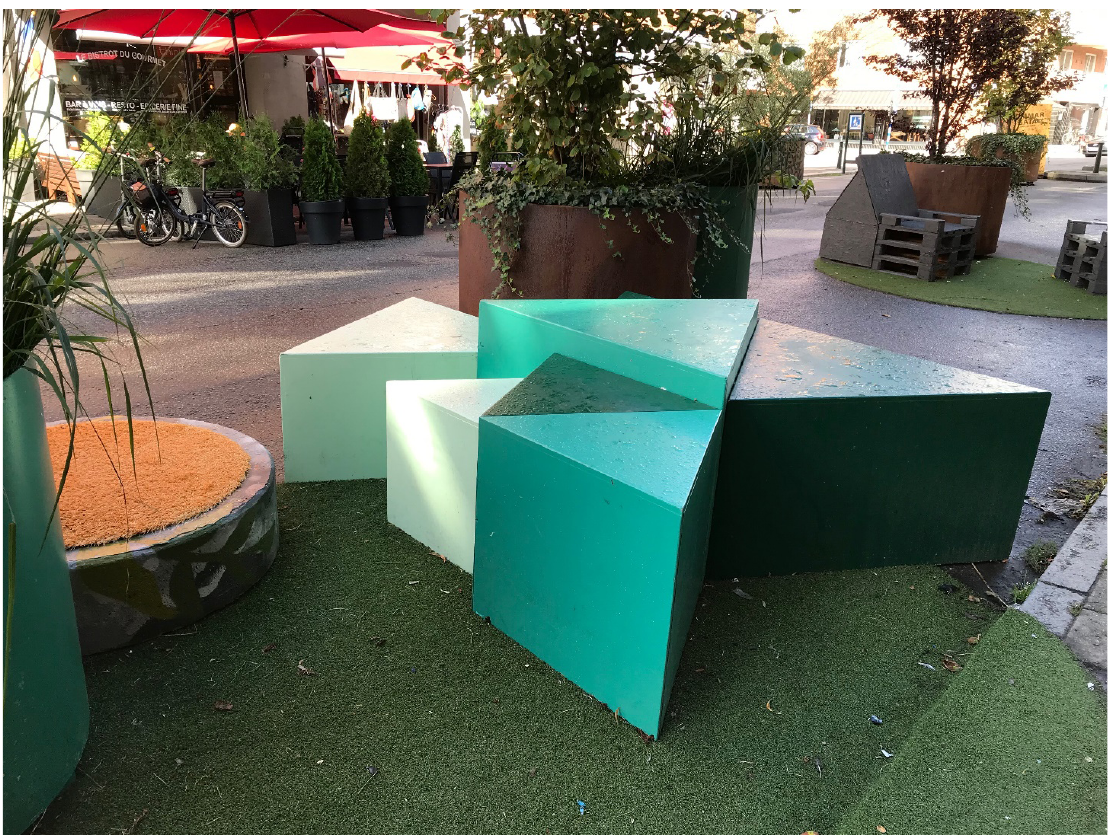
Figure 1. Furniture on a temporary traffic-free street in Malmö, Sweden. Source: Photo by